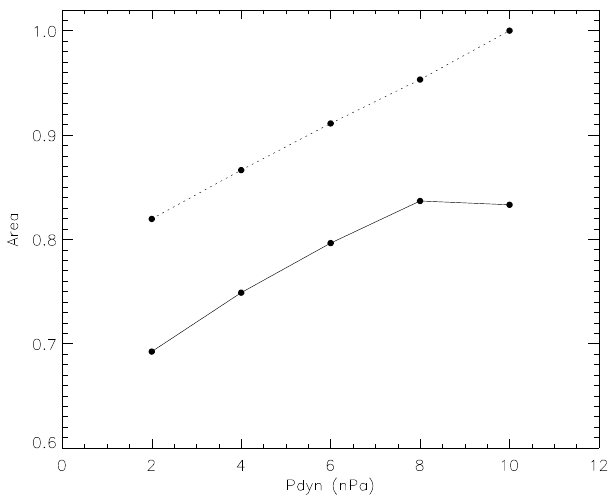
Figure 6. The area of CRW and the solar wind dynamic pressure ( P dyn ) with solid and dotted lines indicating the positive and nega- tive z component of IMF, respectively, all other parameters are the same as that at the quiet time on 6 July 2001, 12:00UT. The y axis has been normalized.